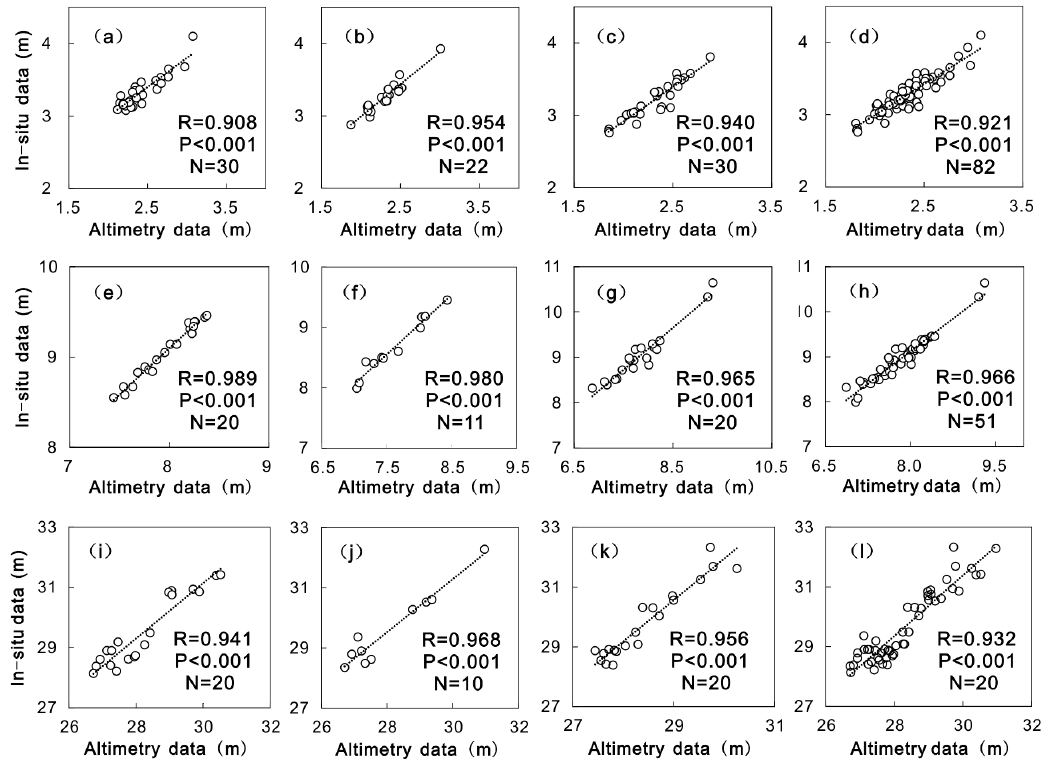
Figure 5. Correlation of Envisat, ICESat-1, Cryosat-2 measurements and the three combined measurements ( x -axis) with the in-situ lake level data ( y -axis) for ( a – d ) Tai Lake, ( e – h ) Chao Lake, and (i-l) South Dongting Lake, respectively. The correlation coefficient (R) and significant level ( P ) are also given. N is the number of observations.